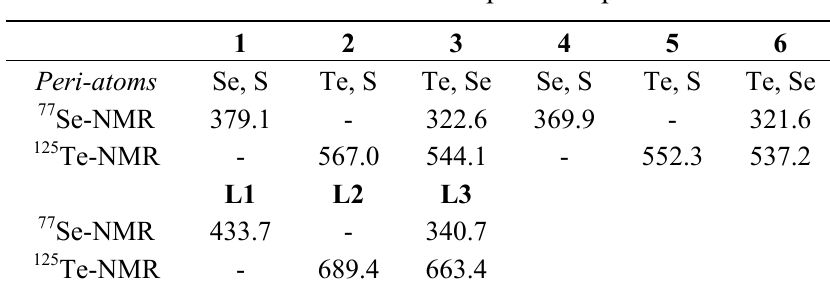
Table 1. 77 Se and 125 Te-NMR spectroscopic data [a]